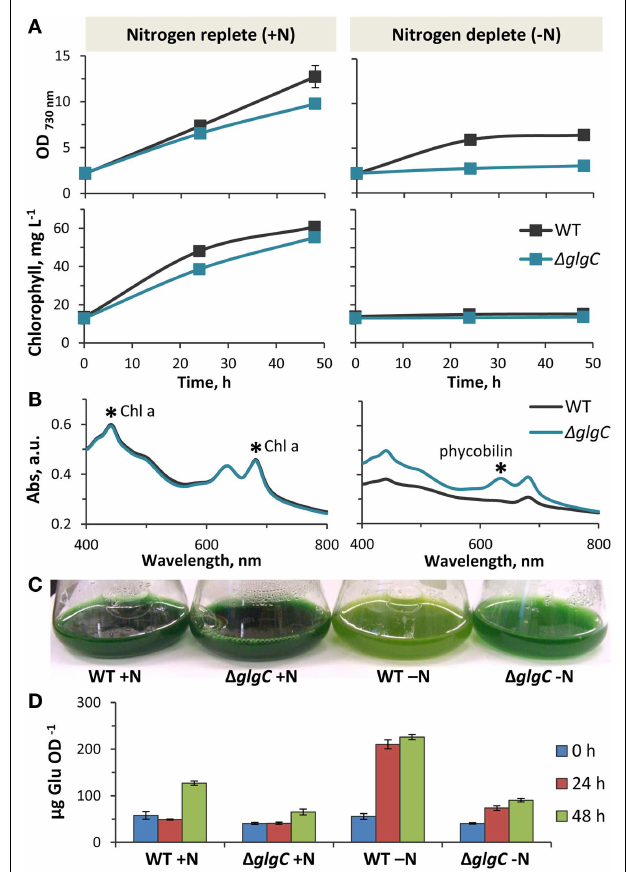
FIGURE 7 | Physiology of Synechococcus sp. PCC 7002 ∆ glg C . (A) . Comparison of photoautotrophic growth rates in wild type and ∆ glgC cultures in nitrogen-replete and nitrogen-deplete media, as measured by changes of optical density (730nm) and chlorophyll content over 48h. (B) Whole cell absorption spectra of wild type and ∆ glgC cells after 48h growth in nitrogen-replete and nitrogen-deplete media. (C) Differences in pigmentation of wild type and ∆ glgC cultures after 48h growth in the presence or absence of nitrogen in the media. (D) Carbohydrate content (reported as glucose equivalents) of wild type and ∆ glgC cells at the different stages of growth (0, 24, and 48h) shown in (A) . Error bars represent standard deviation from three biological replicates, and are hidden beneath the marker if not